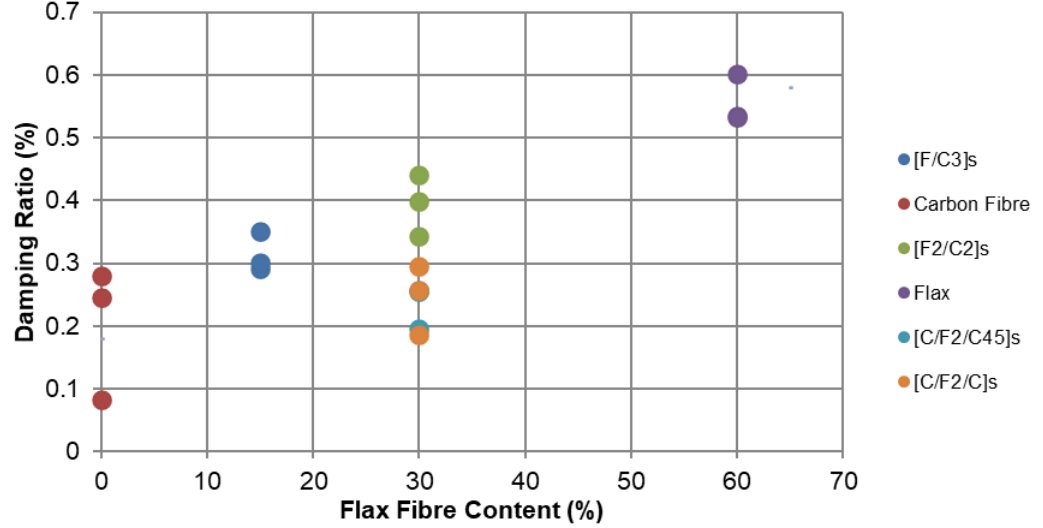
Figure 7. Damping ratios calculated from time-domain measurements. Fibers 2020 , 8 , x FOR PEER REVIEW